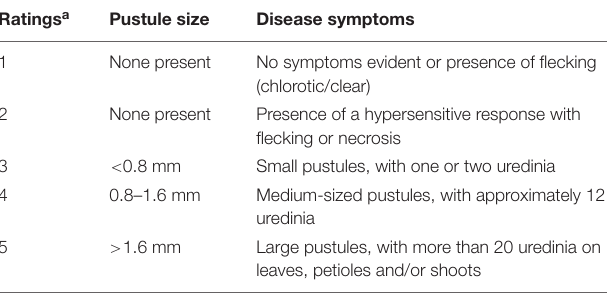
TABLE 1 | Progression of disease symptoms observed on Eucalyptus grandis in response to Austropuccinia psidii